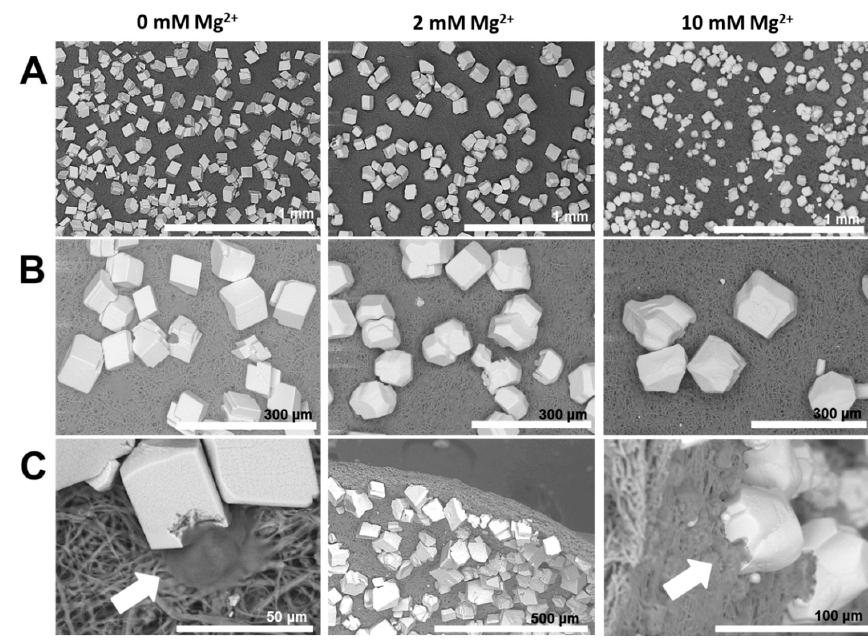
Figure 5. Representative SEM images of the outer surfaces of egg shell membranes mineralized in the presence of PEG (50 ppm) and different Mg 2+ contents. Arrows indicate mammillae-associated crystals.